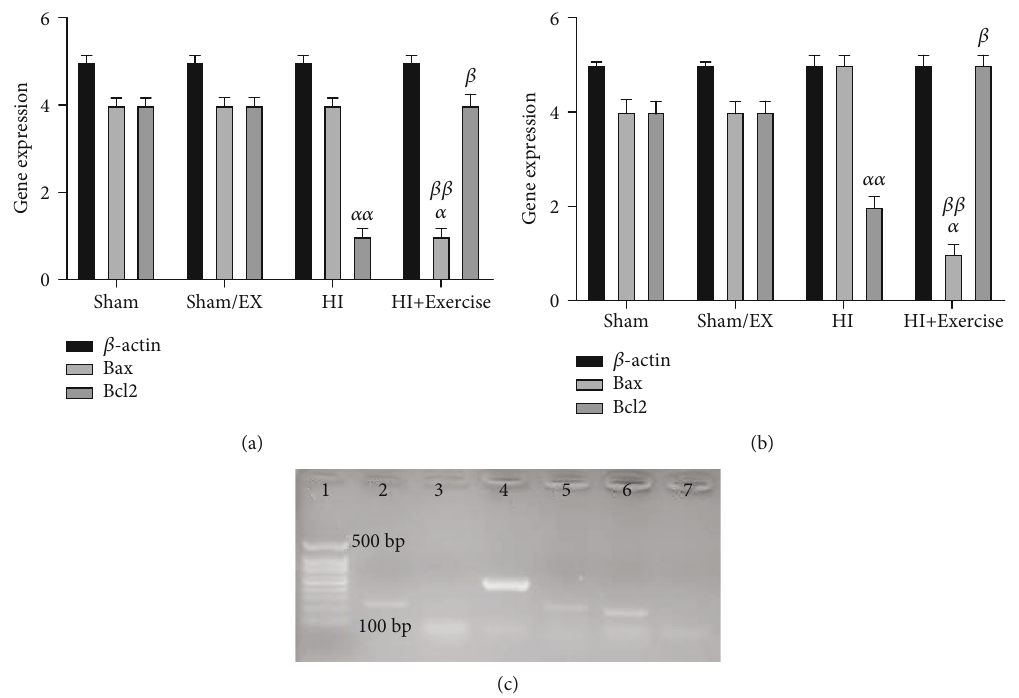
Figure 6: E ff ect of maternal exercise during pregnancy, on Bax and Bcl-2 gene expressions in female (a) and male (b) pups after HI. (c) Representative reverse transcriptase-polymerase chain reaction of β -actin, Bcl-2 and Bax in di ff erent groups. (1) Negative control, (2) Bcl- 2, (3) Bax, (4) β -actin, (5) Bcl-2, (6) Bax, and (7) β -actin. HI: hypoxia-ischemia. α P < 0 : 01 as compared with HI, and αα P < 0 : 05 as compared with the sham and sham/EX. β P < 0 : 05 as compared with the HI, and ββ P < 0 : 01 as compared with the sham and sham/EX. Data are expressed as the mean ± S : E : M : ( n = 10